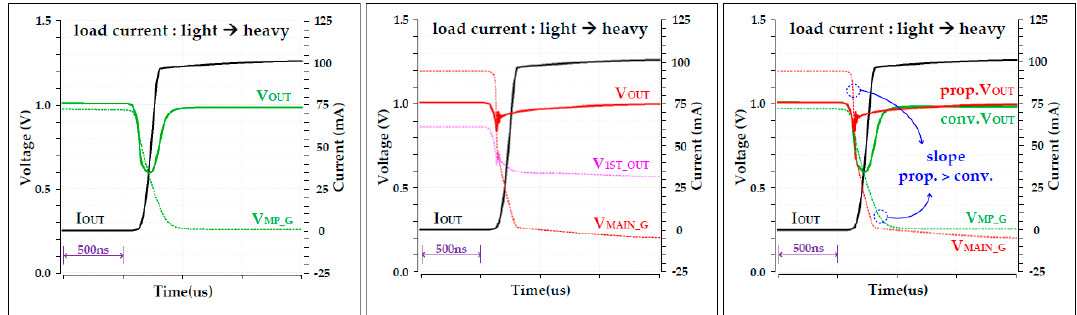
Figure 10. Simulation results of internal nodes’ transient responses: ( a ) conventional LDO regulator, ( b ) proposed LDO regulator and ( c ) comparison between conventional and proposed LDO regulators. (The load current is changed from 0 to 100 mA with 100-ns rising time).